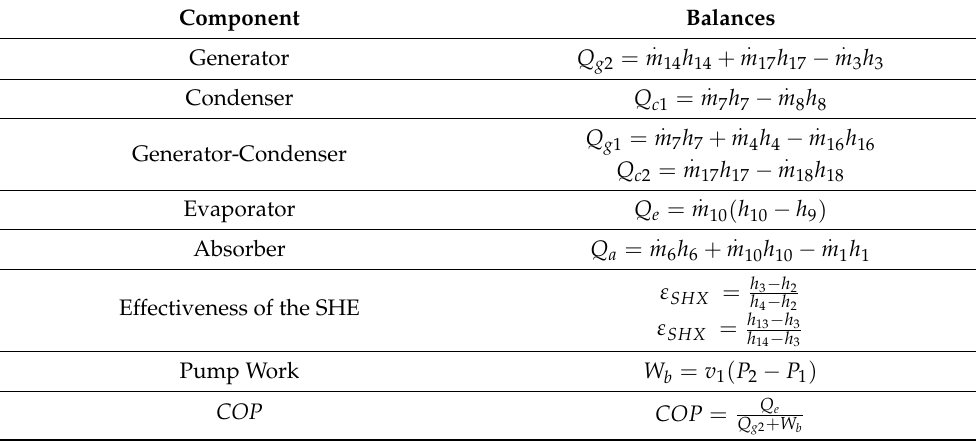
Table A3. Energy balances for each one of the components of the double-effect absorption cooling system.